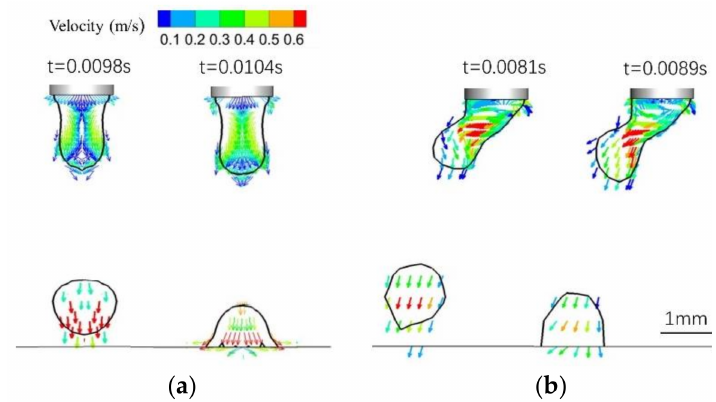
Figure 11. The velocity distribution in the droplet: ( a ) MIG; ( b )